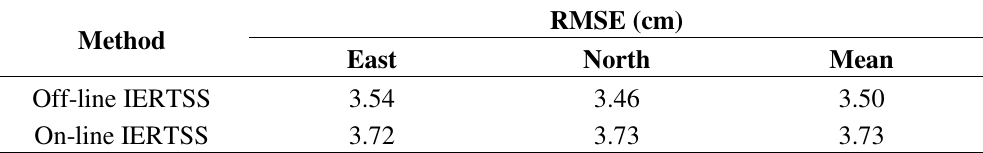
Table 8. Comparison of on-line and off-line mode in terms of position error.